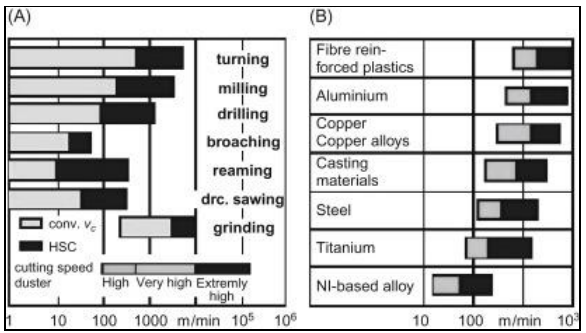
Fig. 1. HSC speed ranges for (a) cutting methods and (b) materials to be processed [11]